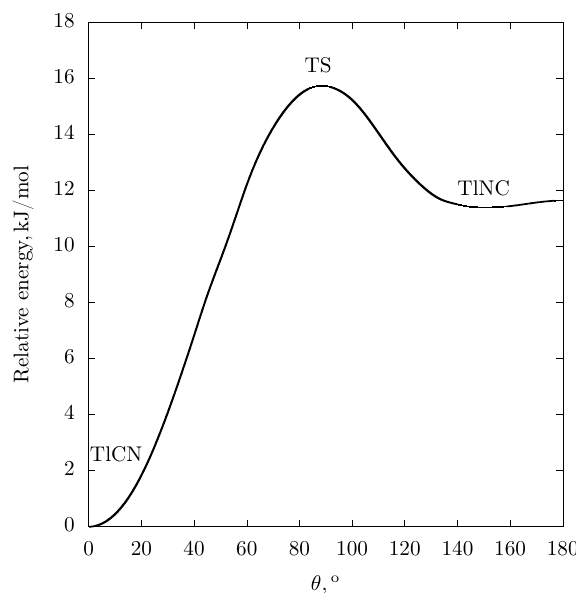
Figure 2. The cross section of RCCSD(T)/CBS potential energy surface for Tl · CN along the approximate isomerization path. TS: transition state. The energy is given with respect to the global minimum. The distance r ( CN ) = 1.16641Å is frozen at the equilibrium value for the TlCN isomer. Table 1. Relative energies (kJ/mol) of isomers and transition states (TS) for M · CN systems. PW: present work.